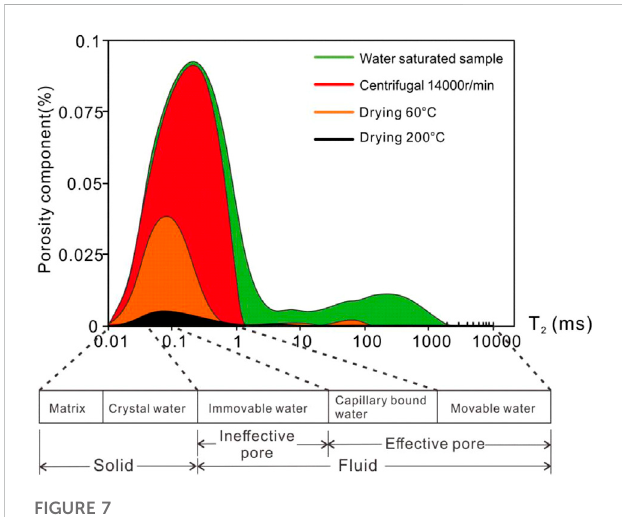
FIGURE 7 Pore fl uid distributioncharacteristics and pore type classi fi cation of transitional